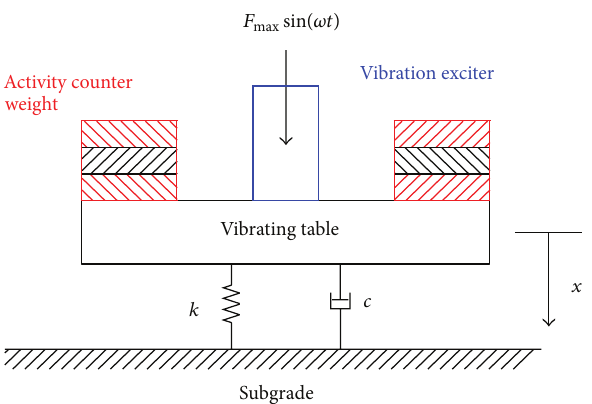
Figure 8: Freedom vibration mode of single degree for the in situ dynamic loading test system.